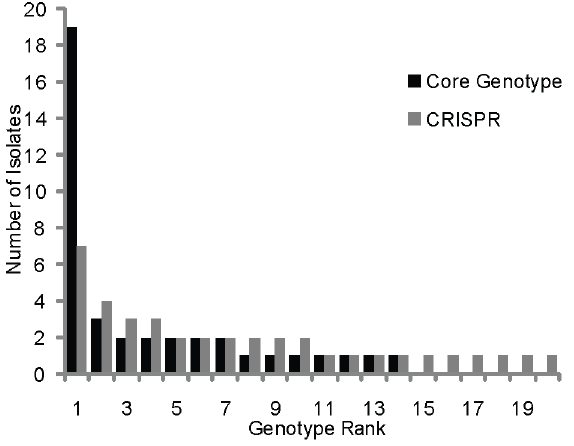
Figure 3. Genotype rank abundance graph of concatenated core and CRISPR end sequences. A genotype rank abundance graph with strains grouped by MLSA core genotypes (black) and CRISPR spacers (grey, by ancestral groupings, as in Figure 1). Groups were ranked by the number of isolates in each and plotted from largest (left) to smallest (right).